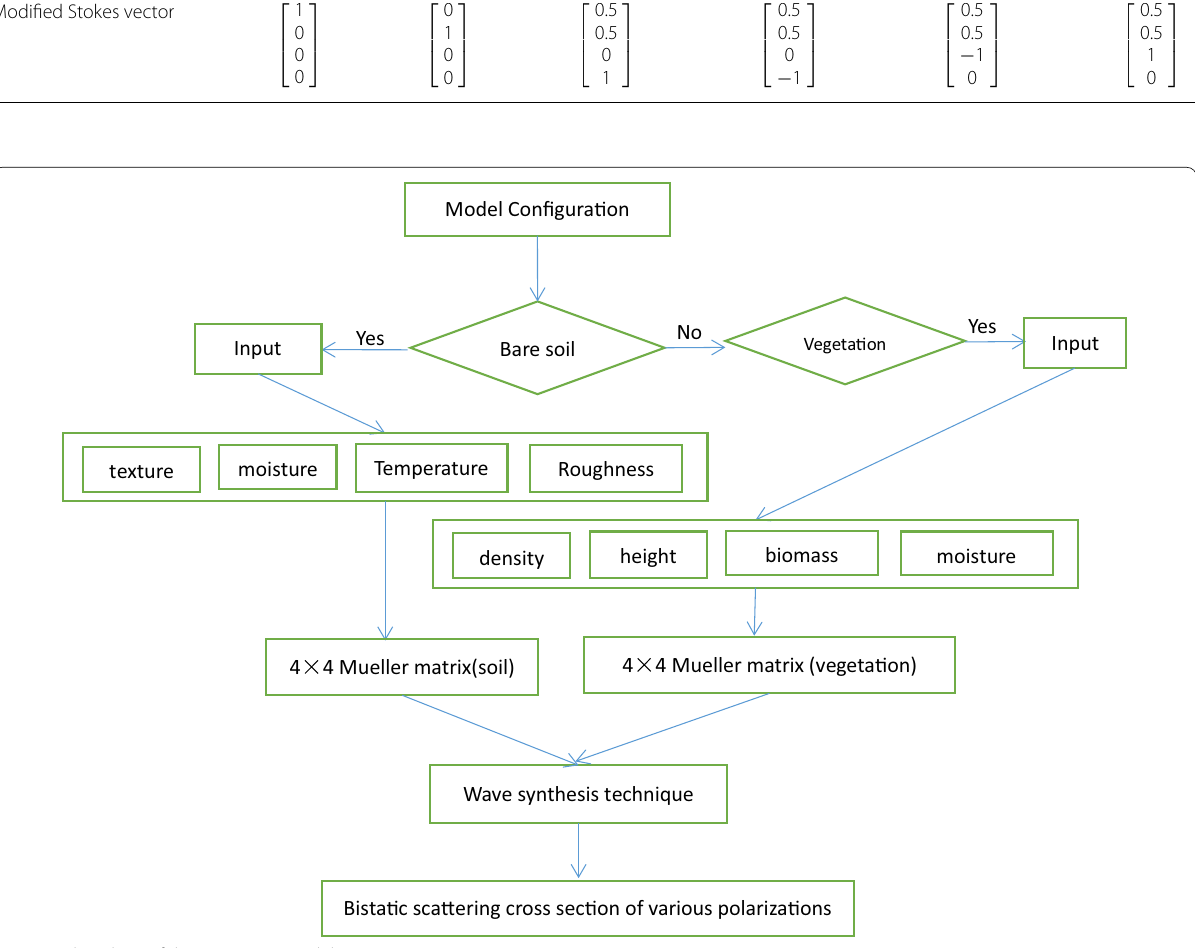
Fig. 3 Flowchart of the scattering